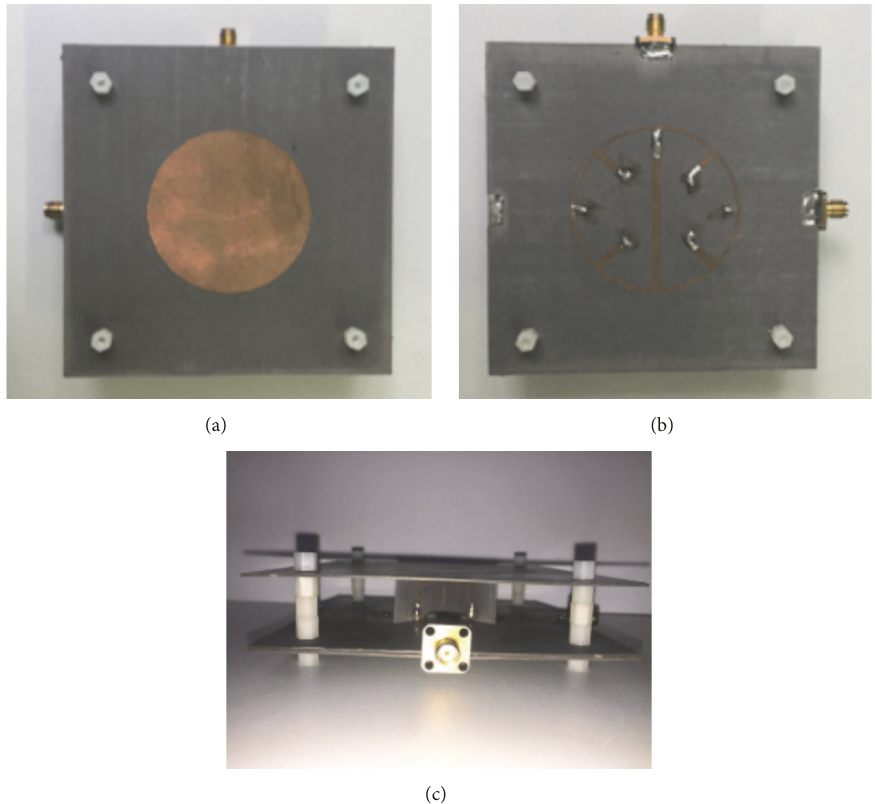
Figure 7: Photograph of the proposed antenna. (a) Top view. (b) Bottom view. (c) Side